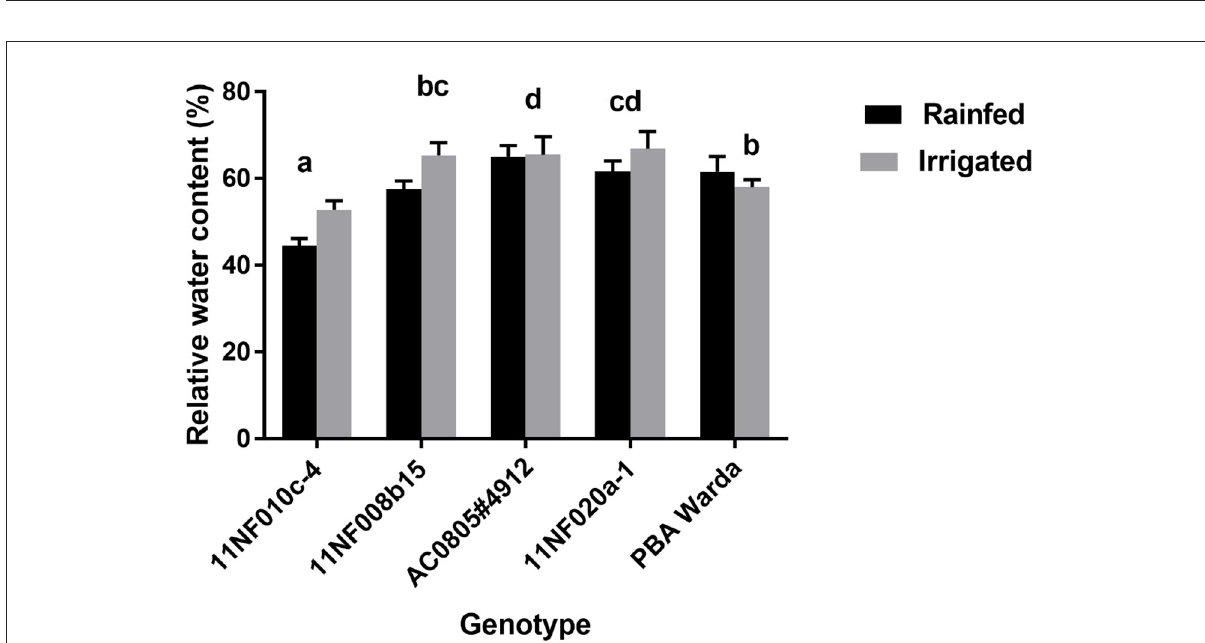
FIGURE3 Relative water content (%) of contrasting faba bean genotypes grown under field conditions (irrigated and rainfed trial) at Narrabri, Australia. RWC was determined at the three-pod stage. Error bars were calculated from four replicates and represent standard error of the mean. Letters denote a significant difference ( p < 0.05) among genotypes calculated through DMRT.